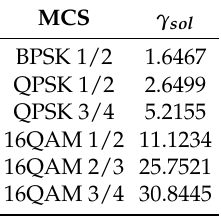
(cid:16) (cid:17) (cid:16) (cid:17) Γ ( 1 ) Γ ( 2 ) γ 2 as functions of γ , for 16QAM-1/2. and f u 3 , m u 1 , m Table 2. Estimated values of γ sol for different